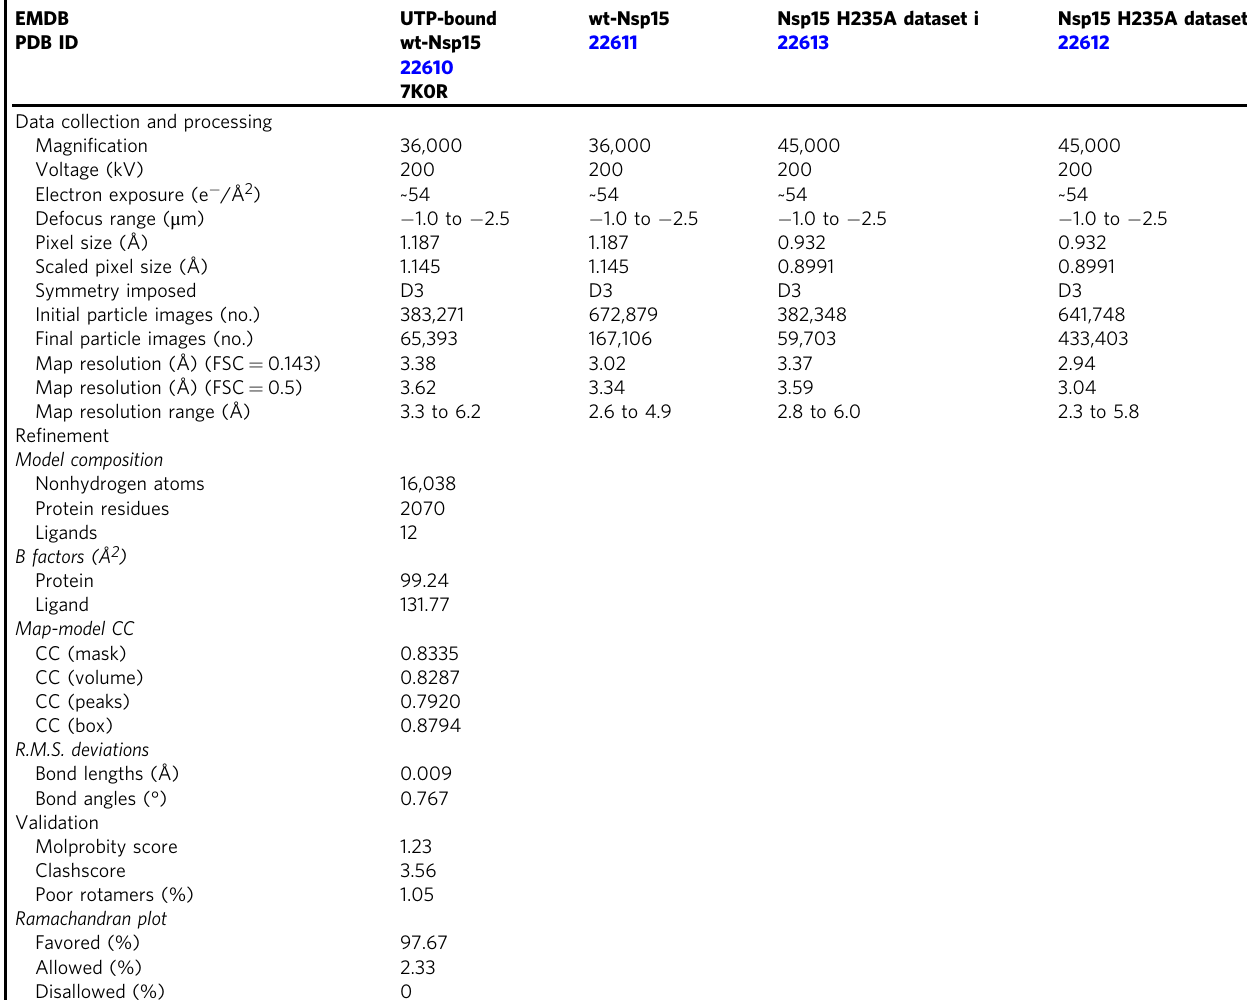
Table 1 Cryo-EM data collection, re fi nement, and validation